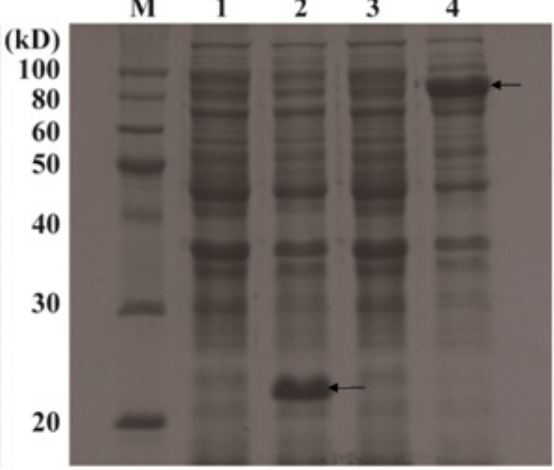
Figure 5. SDS-PAGE analysis of OsPOP5 overexpression in E. coli BL21. M marker (Protein Ruler II); lane 1 untreated BL/pET32a; lane 2 BL/pET32a induced by isopropylthio- β - D -galactoside (IPTG) (arrow mark is 21 kD); lane 3 untreated